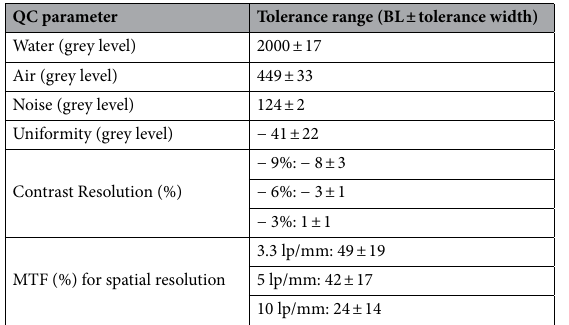
Table 2. Tolerance ranges calculated for all the monitored QC parameters for the Quantum GX micro-CT (PerkinElmer, Inc. Waltham,